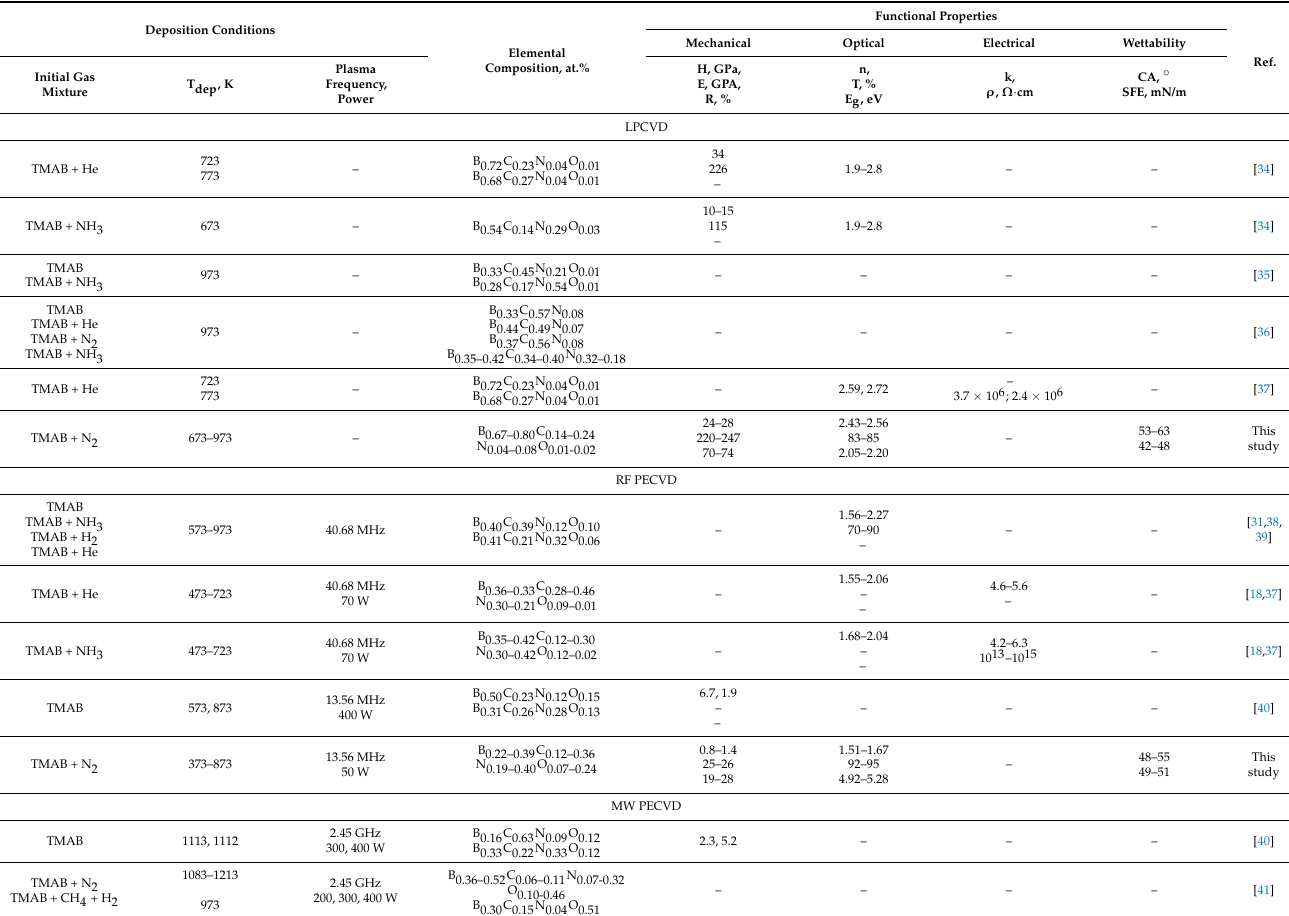
Table 1. Deposition parameters of BC x N y films via decomposition of trimethylamine borane and films’ functional